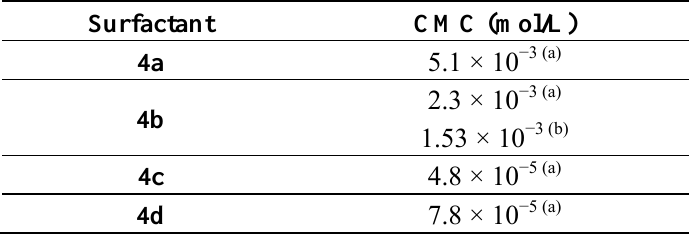
Table 2. Critical micelle concentration (CMC) determined by ( a ) conductivity measurements; and ( b ) by self-diffusion NMR for gemini surfactants 4a–d . The error is on the last